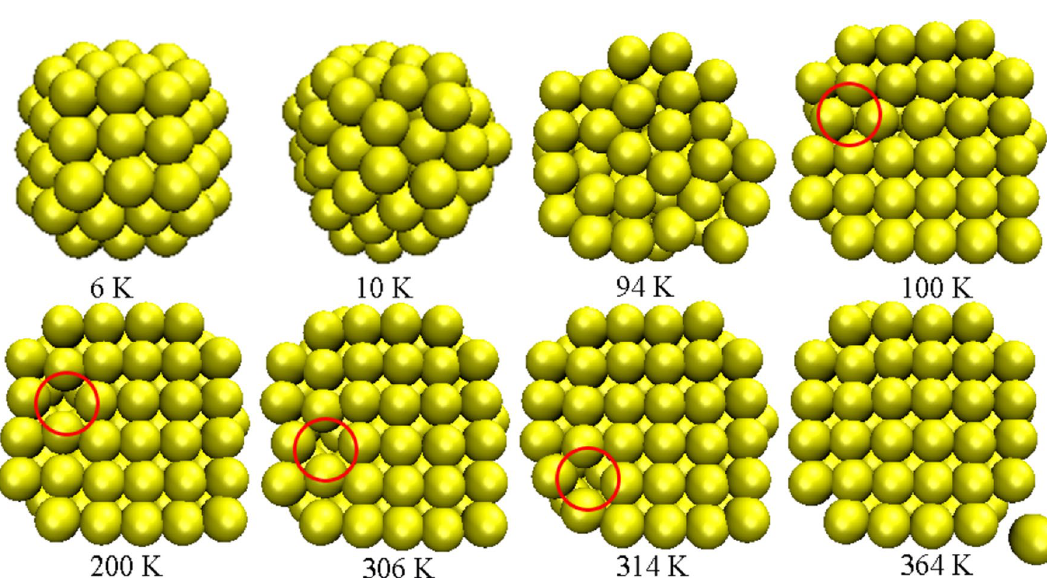
Figure 3. Snapshots of cross sections of Au atoms in the Au-Ni bimetallic NPs taken at eight representative temperatures (unchanged of (100) face of Ni atoms, as shown in the Fig.